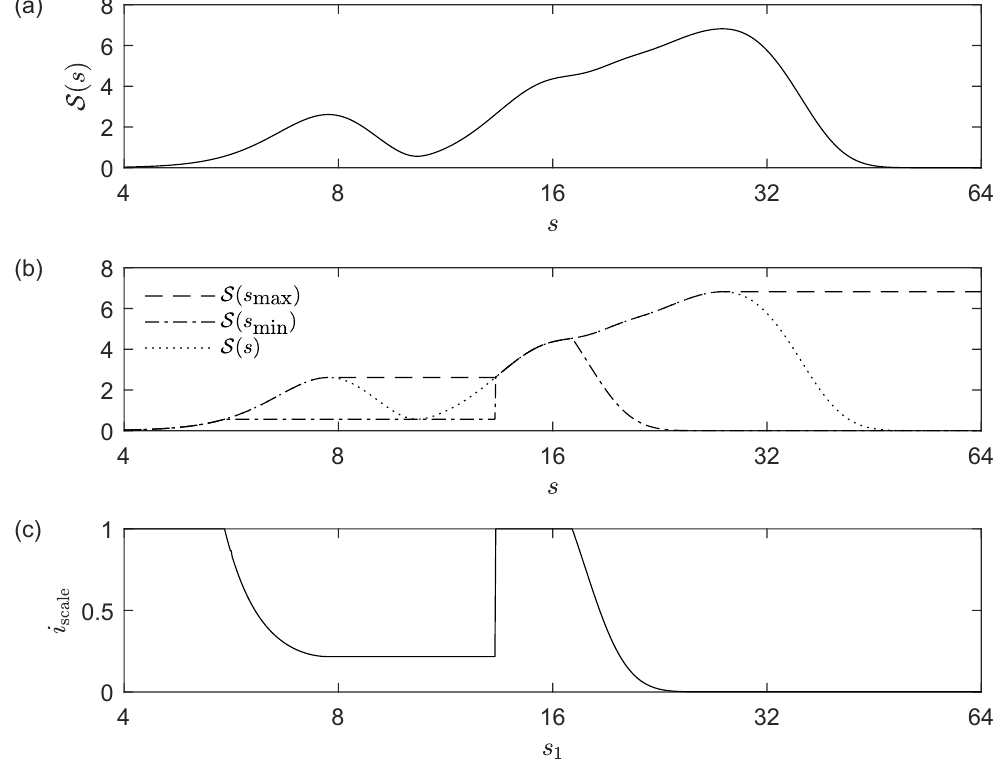
(cid:16) (cid:17) 2 π t sin with t ∈ [ 0,1000 ] and i = 1 T i